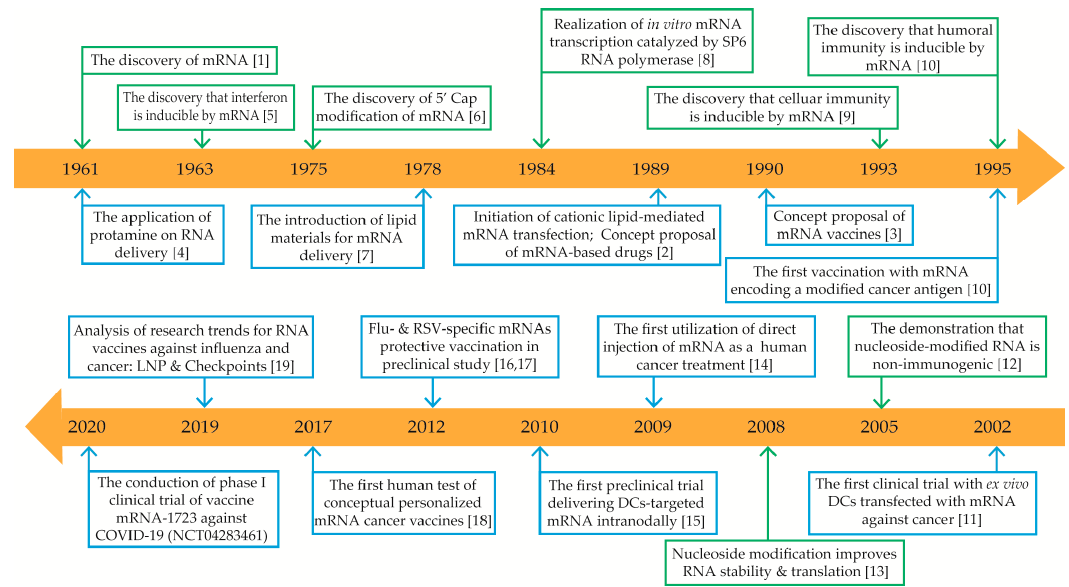
Figure 1. Timeline of some key discoveries and advances in the development of mRNA-based drug technology. Green boxes represent discoveries and advances in mRNA mechanisms; blue boxes represent discoveries and advances in mRNA-based drug applications. Abbreviations: mRNA, messenger RNA; 5 ′ cap, five-prime cap; LNP, lipid nanoparticles; COVID-19, coronavirus disease 2019; DCs, dendritic cells.